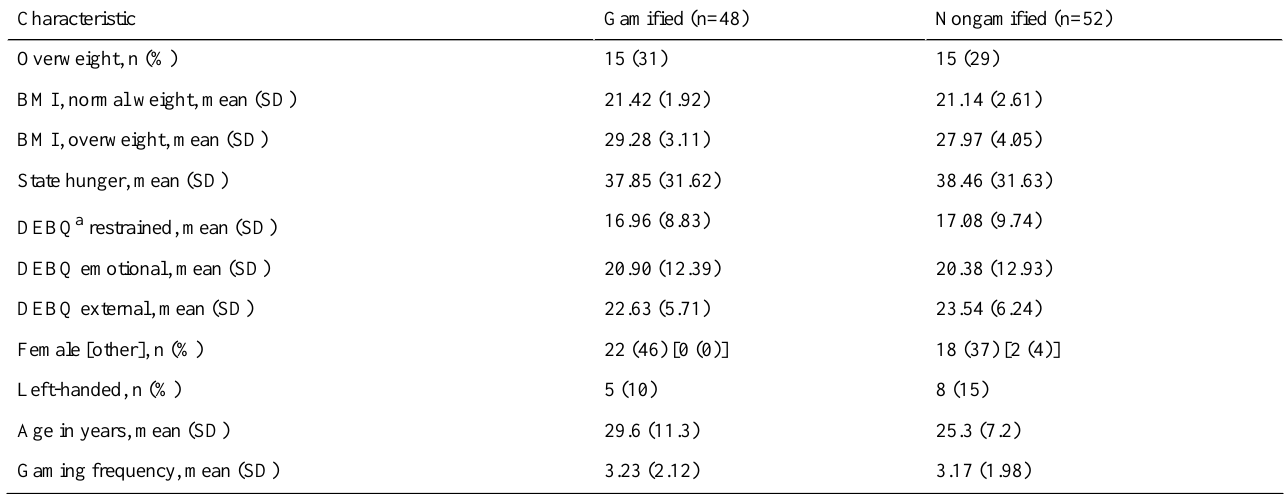
Table 1. User statistics for the gamified and nongamified